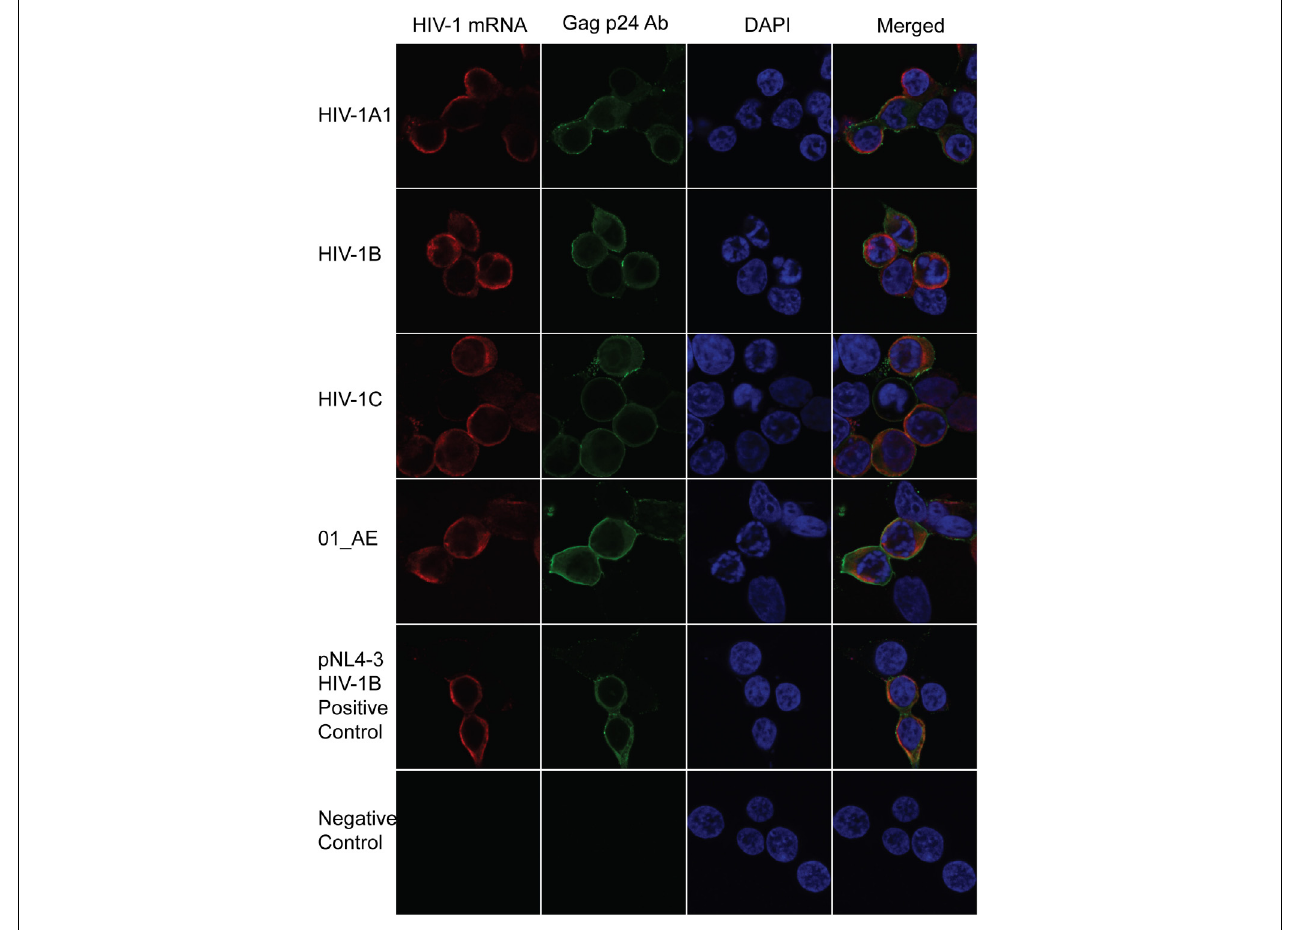
FIGURE 5 | Subtype specificity of RNAscope using patients derived chimeric viruses of HIV-1 subtypes. Chimeric viruses having HIV-1A1, B, C and CRF 01_AE gag-pol recombinant plasmids were transfected in 293T cells. HIV-1 mRNA and p24 Gag protein was detected 24 h post-transfection by RNAscope and antibody